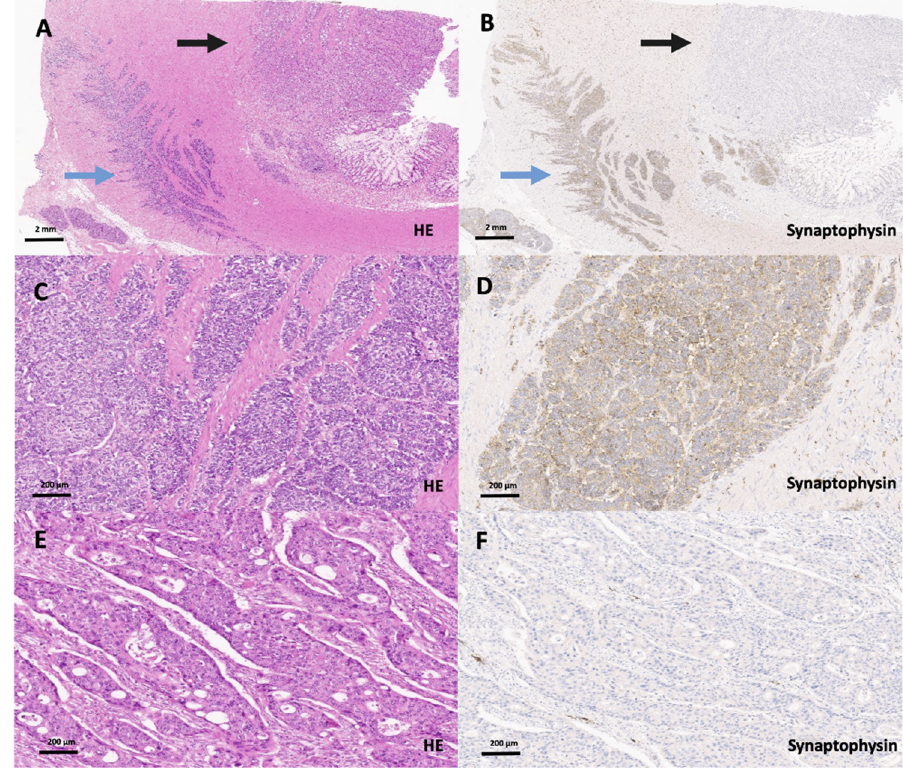
Figure 2. Scanning magnification ( A , HE, 2 × ; B , synaptophysin, 2 × ) of a true colorectal MANEC (blue arrow: NEC, black arrow: adenocarcinoma component). Higher magnification of the NEC component on H&E ( C , 20 × ) and synaptophysin staining ( D , 20 × ) showing the typical NEC mor- phology. Higher magnification of the poorly differentiated, synaptophysin-negative adenocarcinoma component ( E , HE, 20×; F , synaptophysin, 20×) of this colorectal MANEC that does not show a neuroendocrine histomorphology.